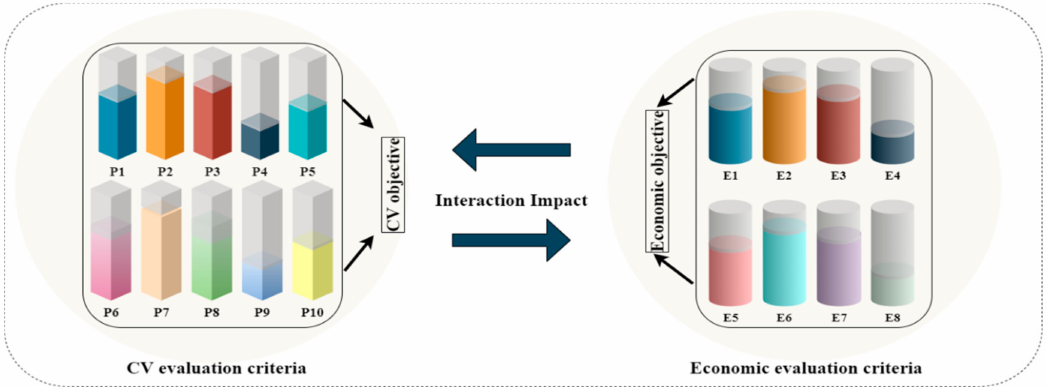
Figure 3. Impact relationship between evaluation objectives.